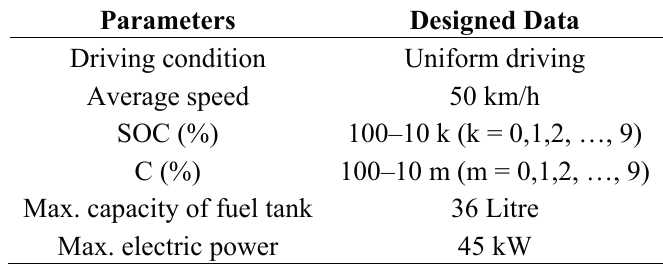
Table 3. Scenario settings for the comparison of FGAS versus TGAS.